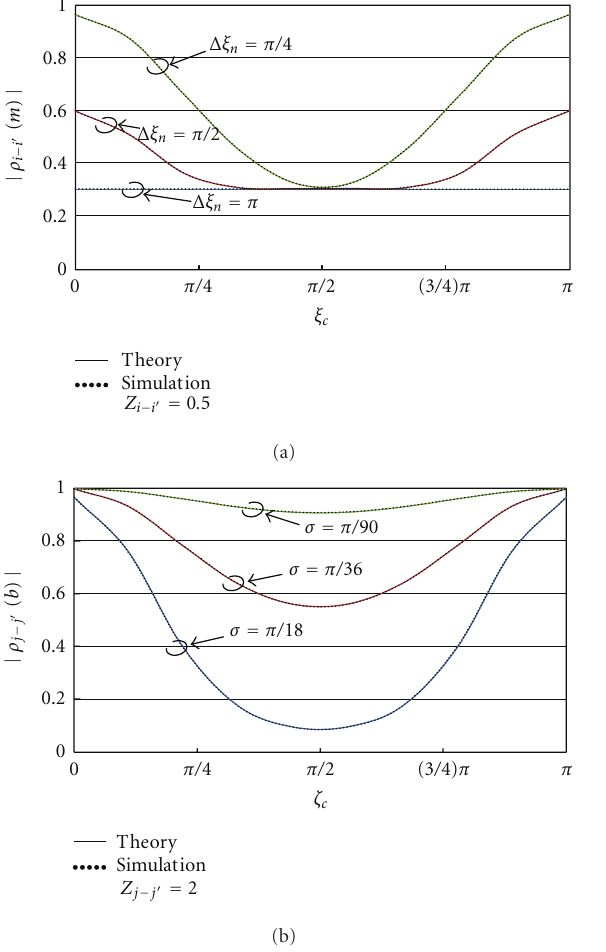
Figure 4: Correlation of dependence on arrival angle for one-side channel. (a) Uniform distribution. (b) Gaussian distribution.